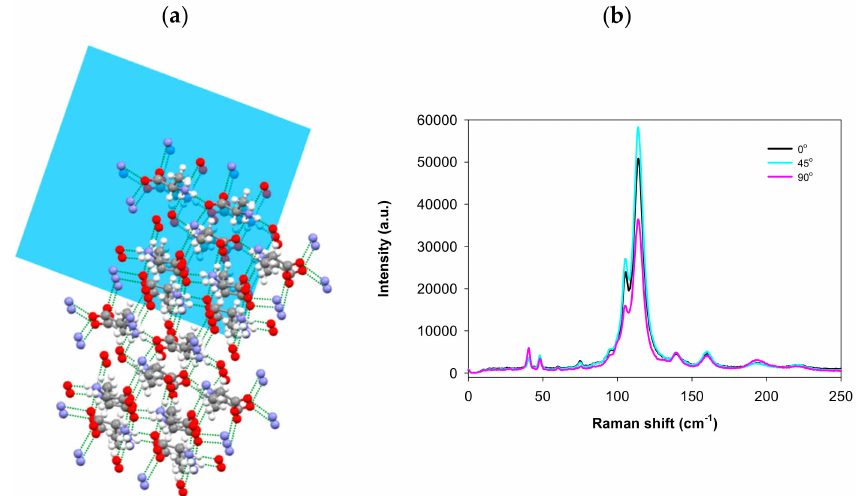
Figure 4. ( a ) Simulation of hydrogen bonds (dotted lines) in the L-alanine single crystal relative to the (011) plane. ( b ) LF-Raman spectra of the crystal excited from the (011) plane in three beam polarization directions: zero (black), 45 (cyan), and 90 (pink)